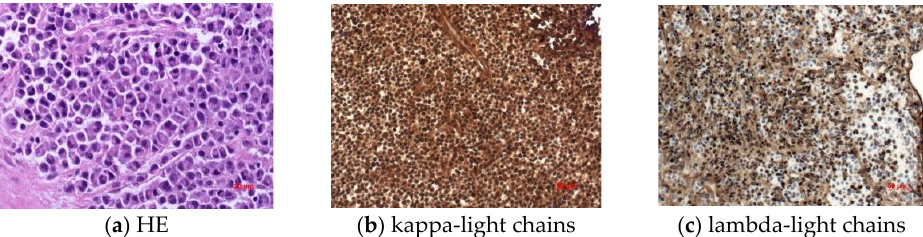
Figure 1. Immunohistochemical work-up to show kappa light chains ( b ) as well as lambda light chains ( c ) compared to standard HE staining ( a ).